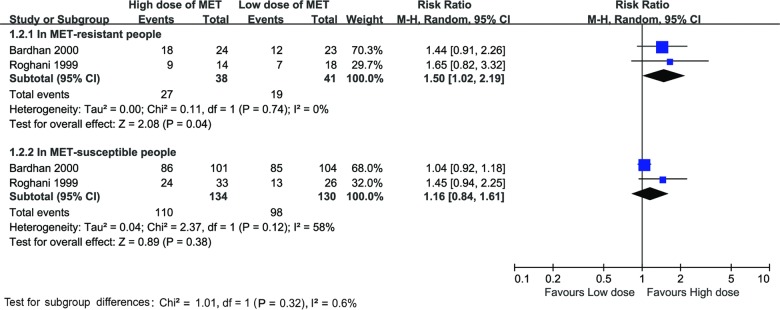
Forest plot of H. pylori eradication rate with high-dose therapies compared to low-dose therapies in the metronidazole-resistant vs. susceptible people.A. Comparison of the high-dose therapies with low-dose therapies in metronidazole-resistant people. B. Comparison of the high-dose therapies with low-dose therapies in metronidazole-susceptible people.